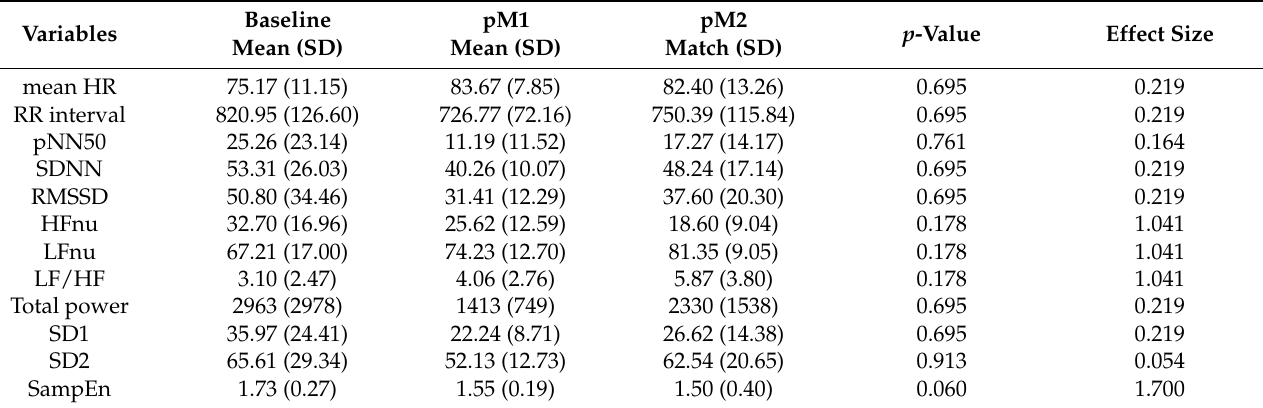
Table 2. Evolution of the pre-match HRV in young elite international tennis players during the ITF Junior Davis